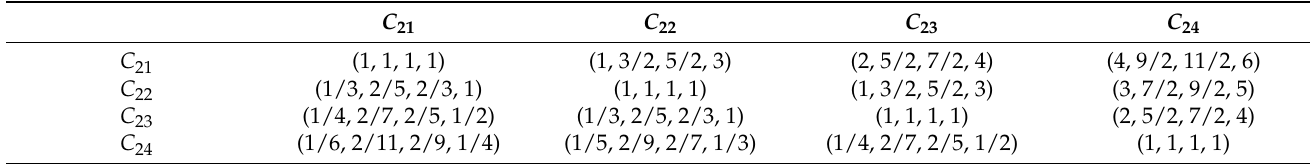
Table A3. Pair-wise comparison matrix of the sub-factor: functionality ( C 2 ).